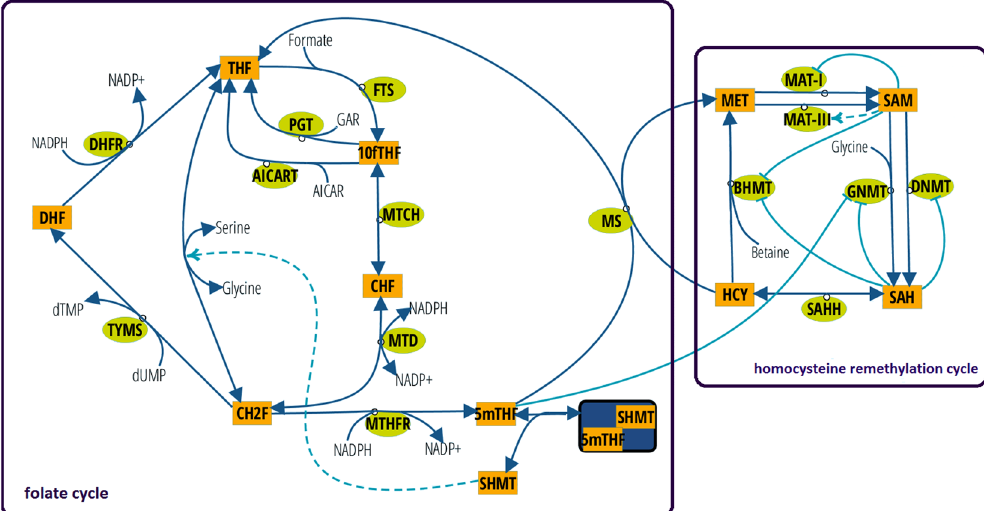
Figure 1. The reaction-based specification of the model according to the notation introduced in Gostner et al . 61 . Rectangles identify model variables, non-boxed substrates are model constants, green circles identify enzymes, dark blue arcs identify matter transformation, and light blue arcs identify regulatory events (dotted lines indicate activations and solid lines indicate inhibitions). The purple boxes indicate reactions and variables associated with the folate cycle and the homocysteine remethylation cycle,